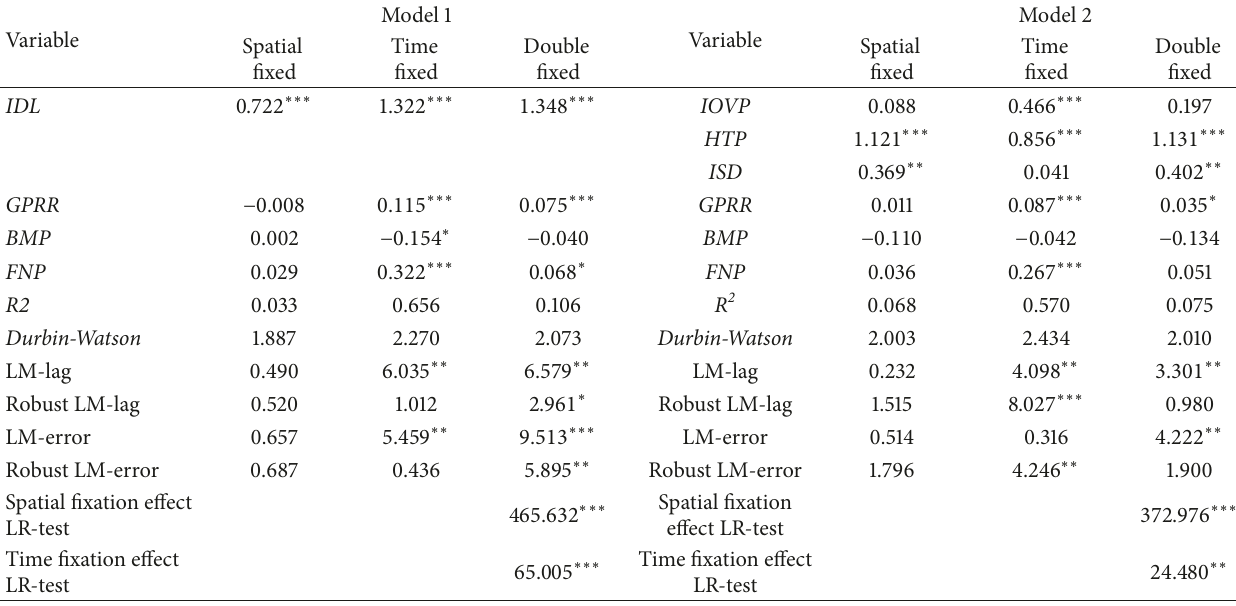
Table 2: Results of OLS estimation and spatial correlation testing.